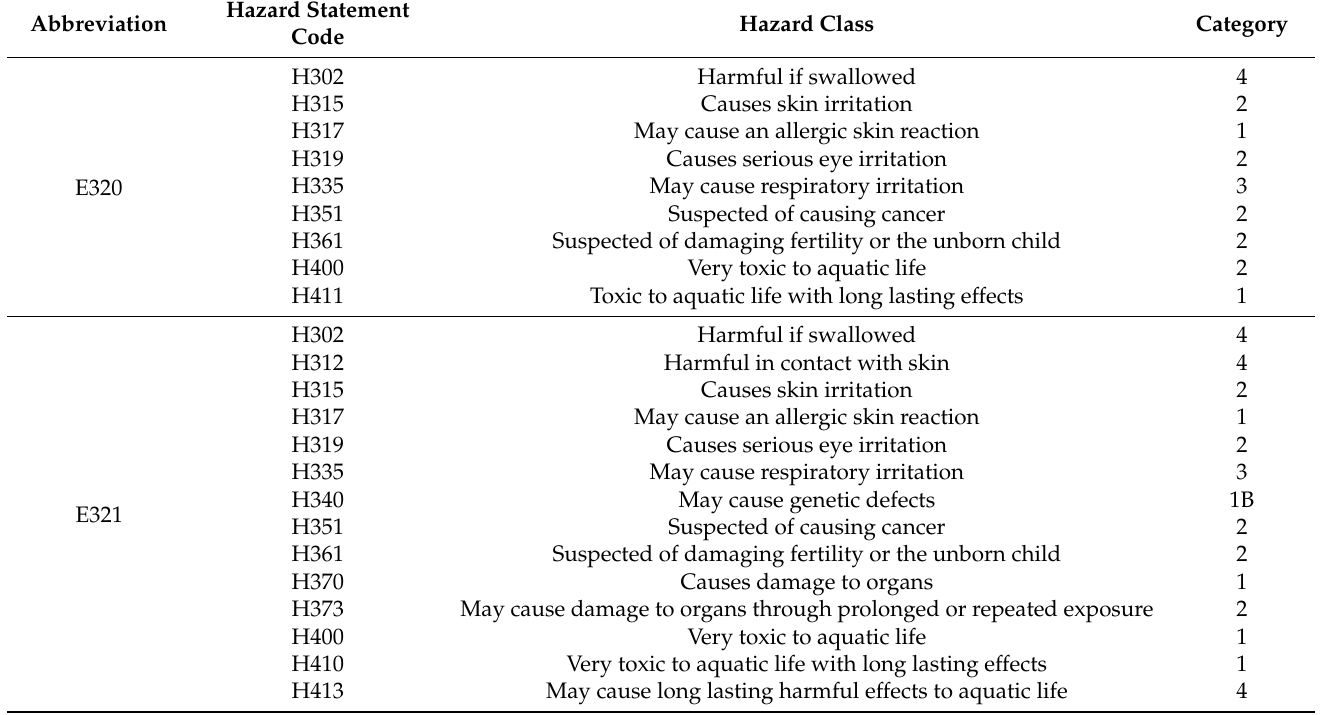
Table 6. Health hazards classification of food additives identified in tested swimming pools